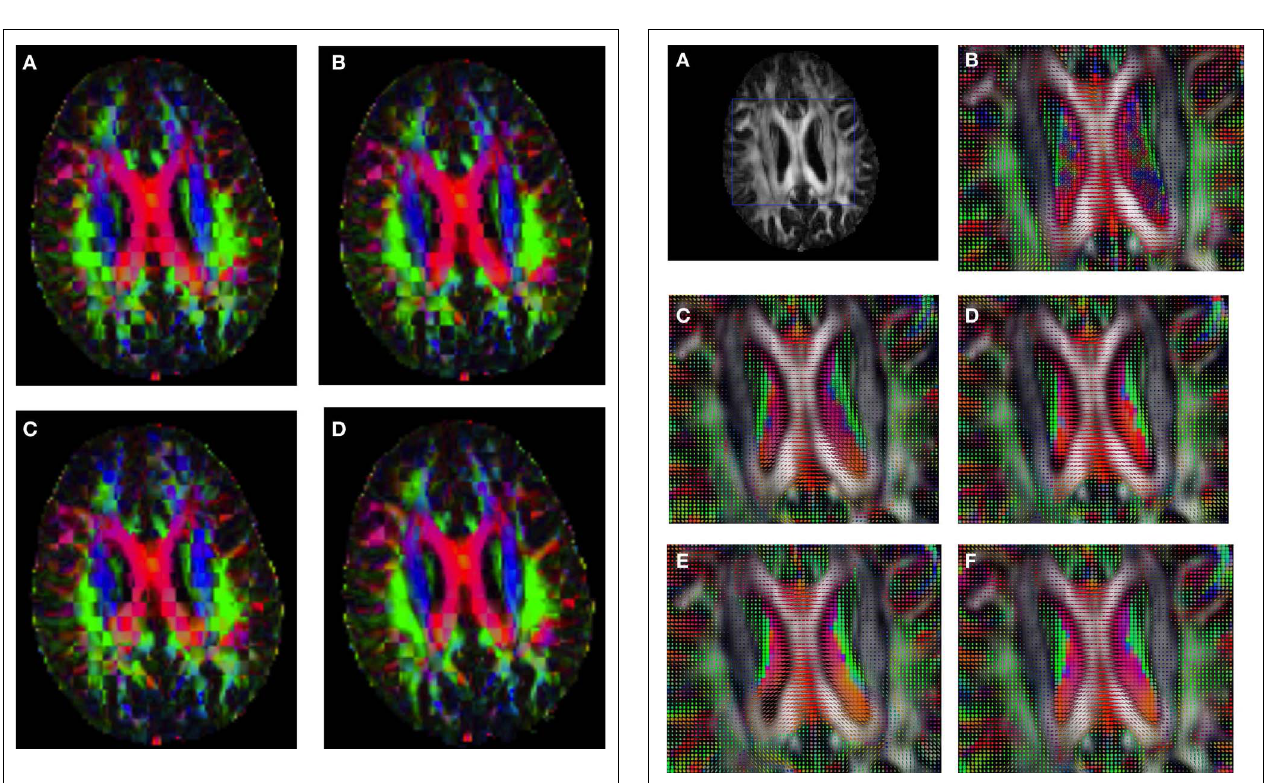
FIGURE 8 | Checkerboard comparison of the RGB color coded main diffusion direction between Subject3 and Subject2 registered to Subject3 using (A) FNIRT-volumes-SH. (B) FNIRT4D-AI. (C) MedINRIA-volumes-SH, (D) DTI-TK-volumes-SH.